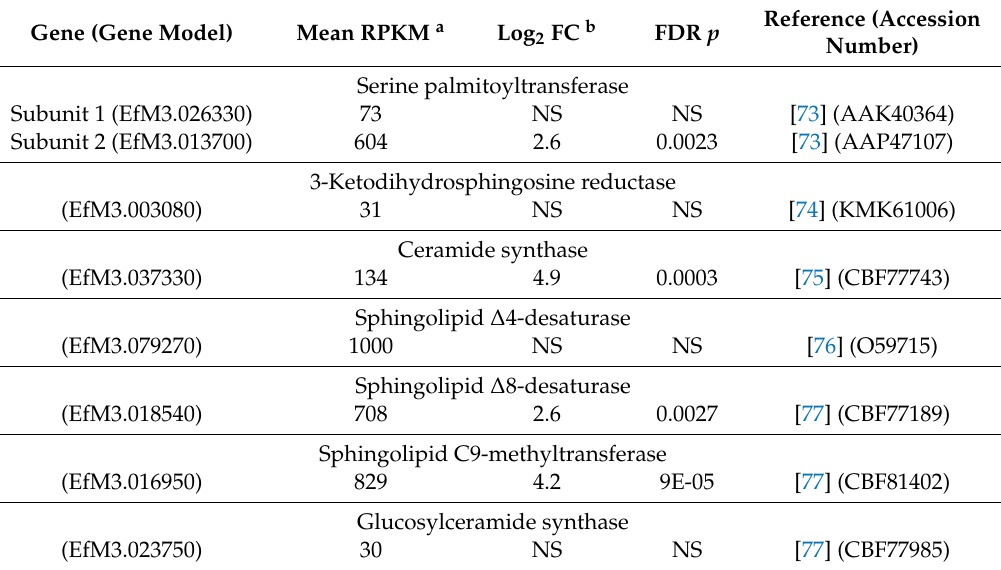
Table 7. Expression of genes for glucosylceramide